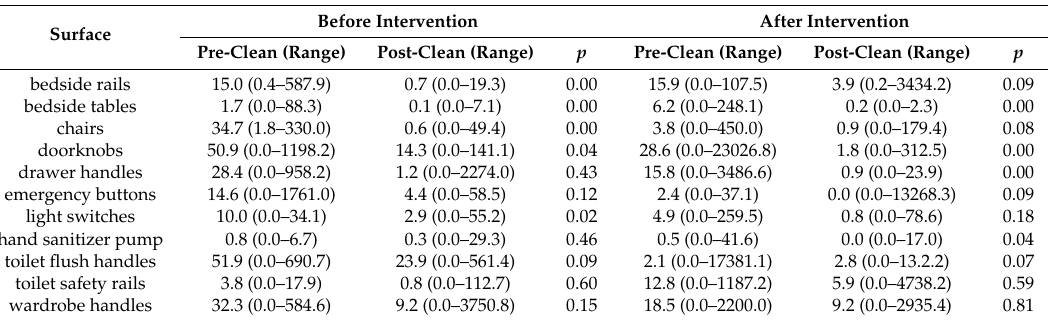
Table 2. Median ACC values (CFU/cm 2 ) before and after daily cleaning during the two study periods and p -values determined using the Wilcoxon signed-rank test ( N = 960).